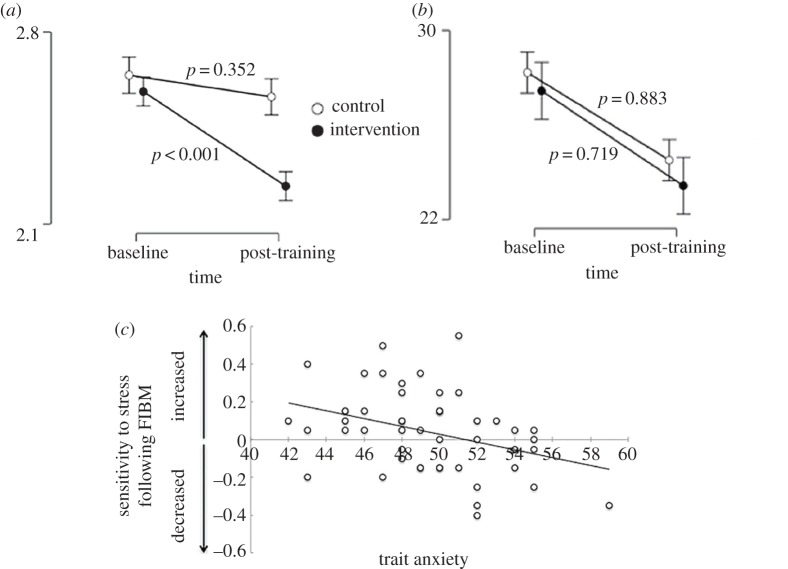
The simple effects across baseline and post-training for (a) Daily Stress Inventory (DSI) average impact rating. (b) DSI frequency measure. Error bars represent s.e.m. (c) Correlations between stress-SART threat-potentiated (threat condition minus safe condition) shift (time 2 minus time 1) and baseline trait anxiety in the FIBM group.